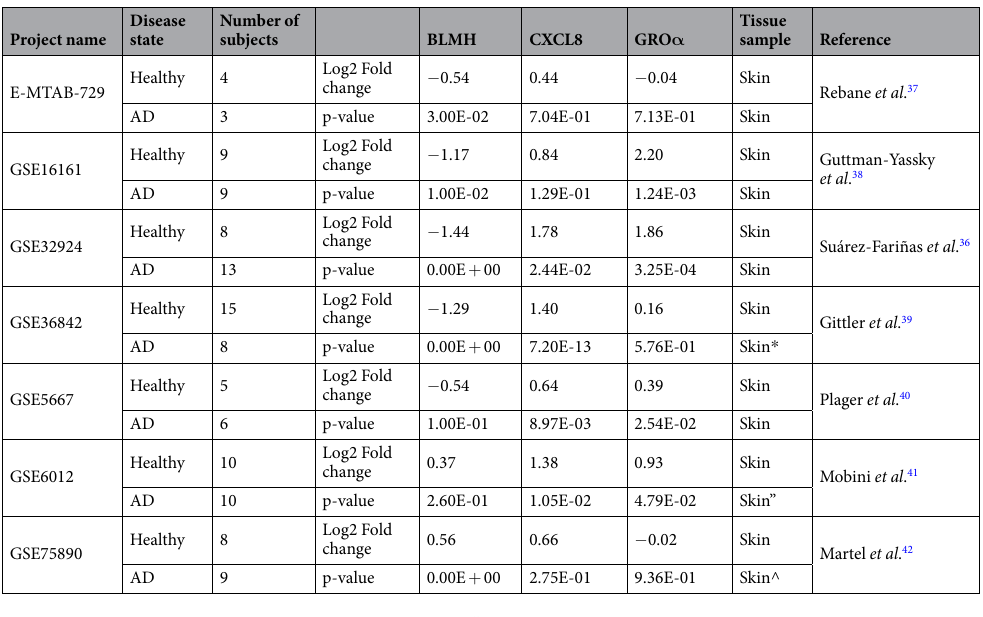
Table 1. Subject characteristics. * acute skin lesions, “skin lesions from atopic eczema, ^intrinsic skin lesions. Age and gender were not provided or accessible for individual subjects in the gene array